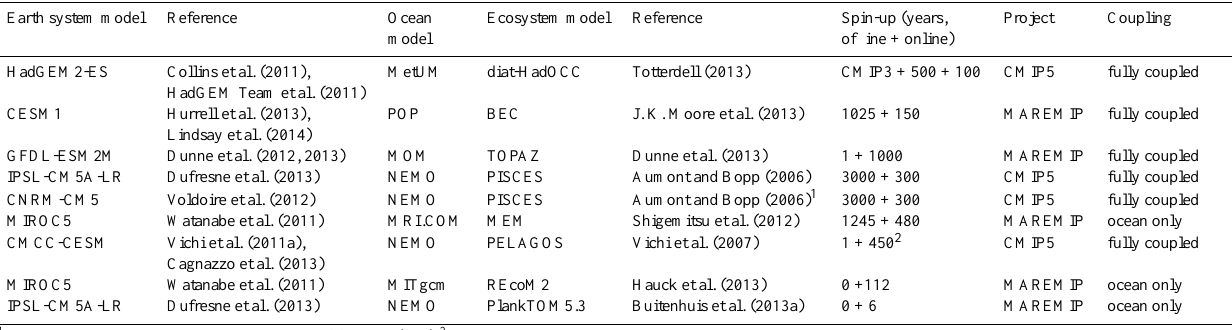
Table 1. Overview of model simulations used in this work.